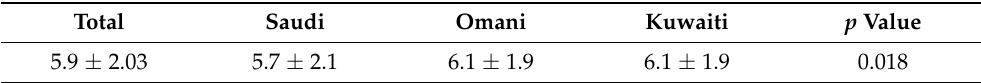
Table 2. Adherence to Mediterranean diet mean score among three gulf countries. Total Saudi